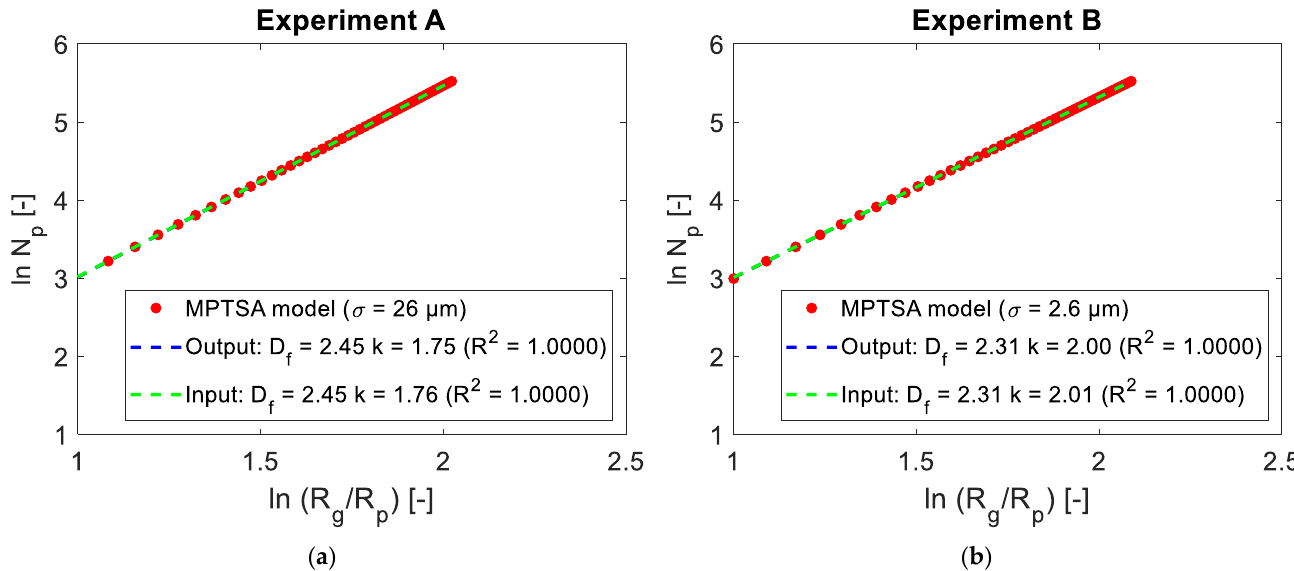
Figure 7. Preservation of fractal properties of agglomerates constructed by means of the MPTSA model for Exp. A ( a ) and Exp. B ( b ).